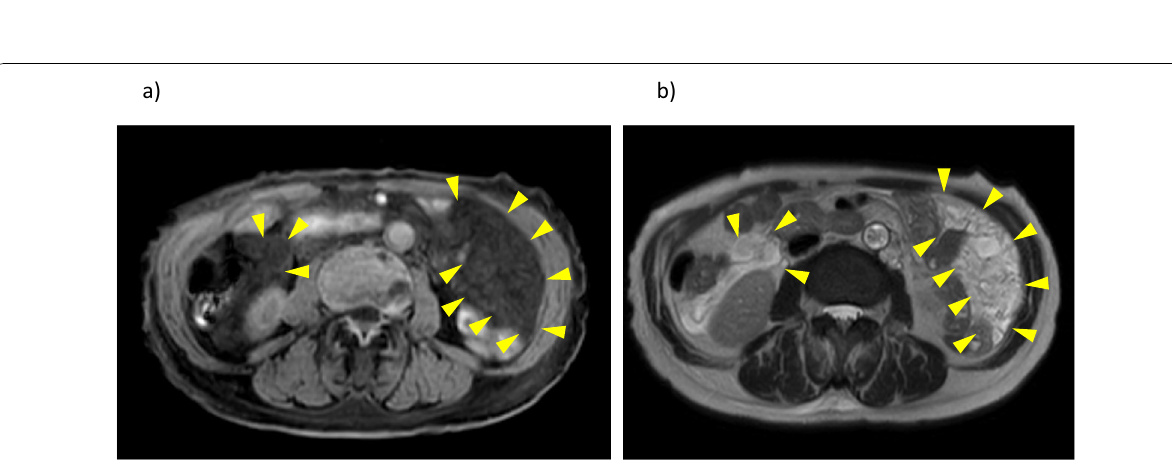
Fig. 2 Abdominal magnetic resonance imaging study: Multiple lesions of a T1-weighted and b T2-weighted sequences, showing respective signal intensities (T1, intermediate; T2, high)